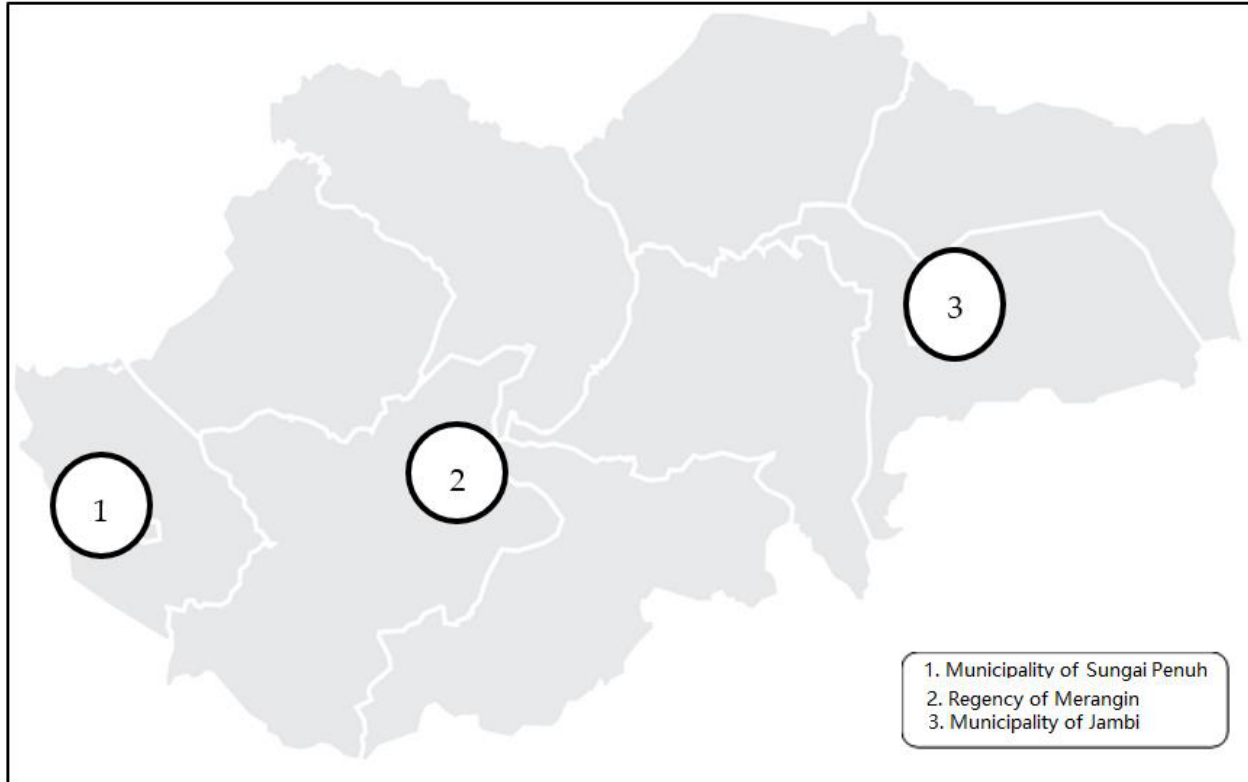
Figure 1. The map of Province of Jambi, Indonesia [22].